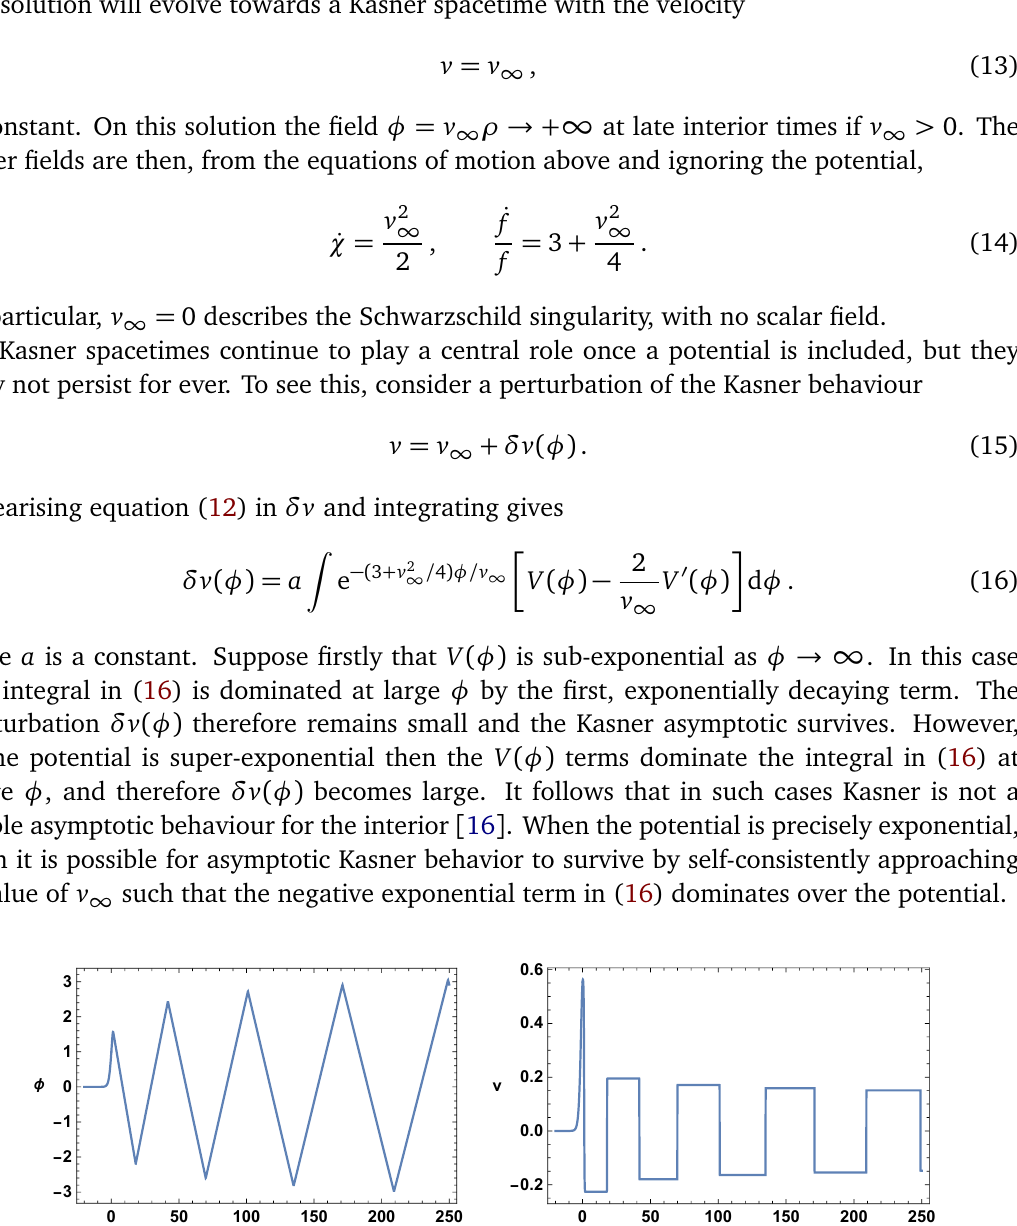
and the singularity at ρ → + ∞ . H (cid:2) 1 φ 8 (cid:3) . exp 10 10 ) = 1. Numerical evolution with a H